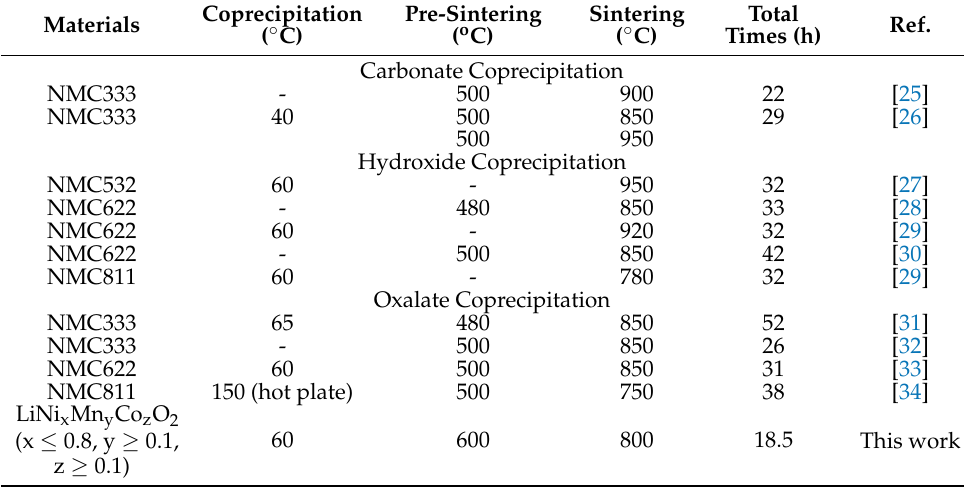
Table 1. Various LiNi x Mn y Co z O 2 (NMC) preparation